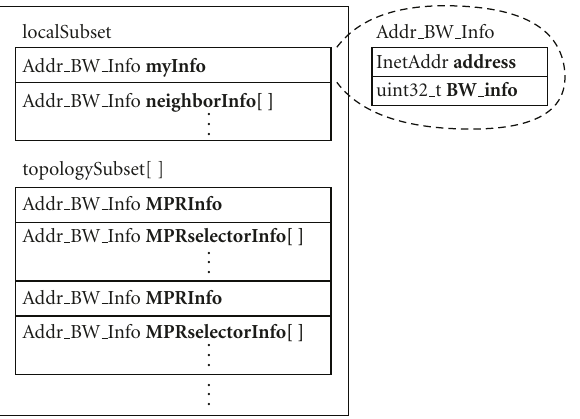
Figure 5: The structure of the Extended Topology